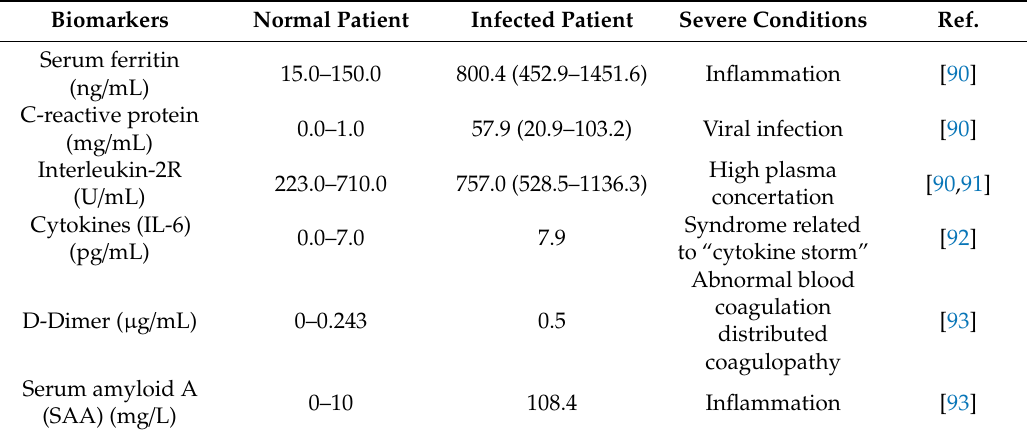
Table 2. List of laboratory tests recommended with common clinical indicators associated with the COVID-19 tests for adult patients.